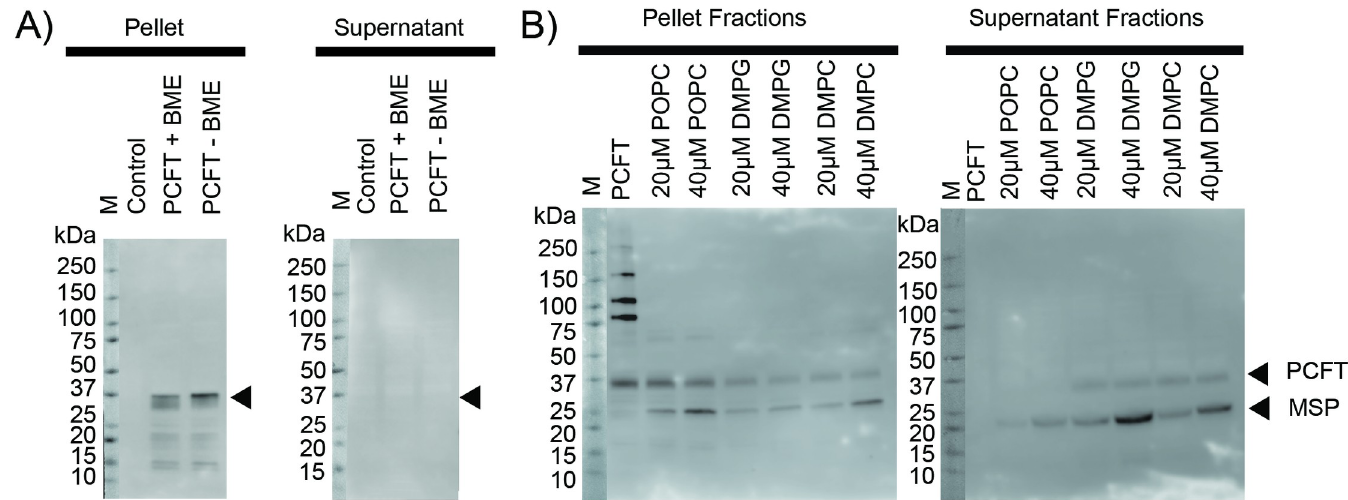
Fig 3. Cell-free expression of Proton-Coupled Folate Transporter (PCFT). The arrows indicate the position of monomeric PCFT (~37 kDa). A) Cell-free expression of PCFT in the absence of LPNs. The “Control” lane reactions did not contain PCFT-pEXP5-NT plasmid. β -mercaptoethanol (BME) was added to some reactions as indicated. B) Cell-free expression of PCFT in the presence of 20 μ M or 40 μ M LPNs containing POPC, DMPG, or DMPC lipids. The “PCFT” lane reactions did not contain any LPNs.